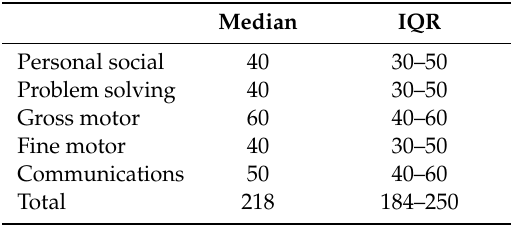
Table 3. Distribution of ASQ-3 total and subscale scores ( n = 305).